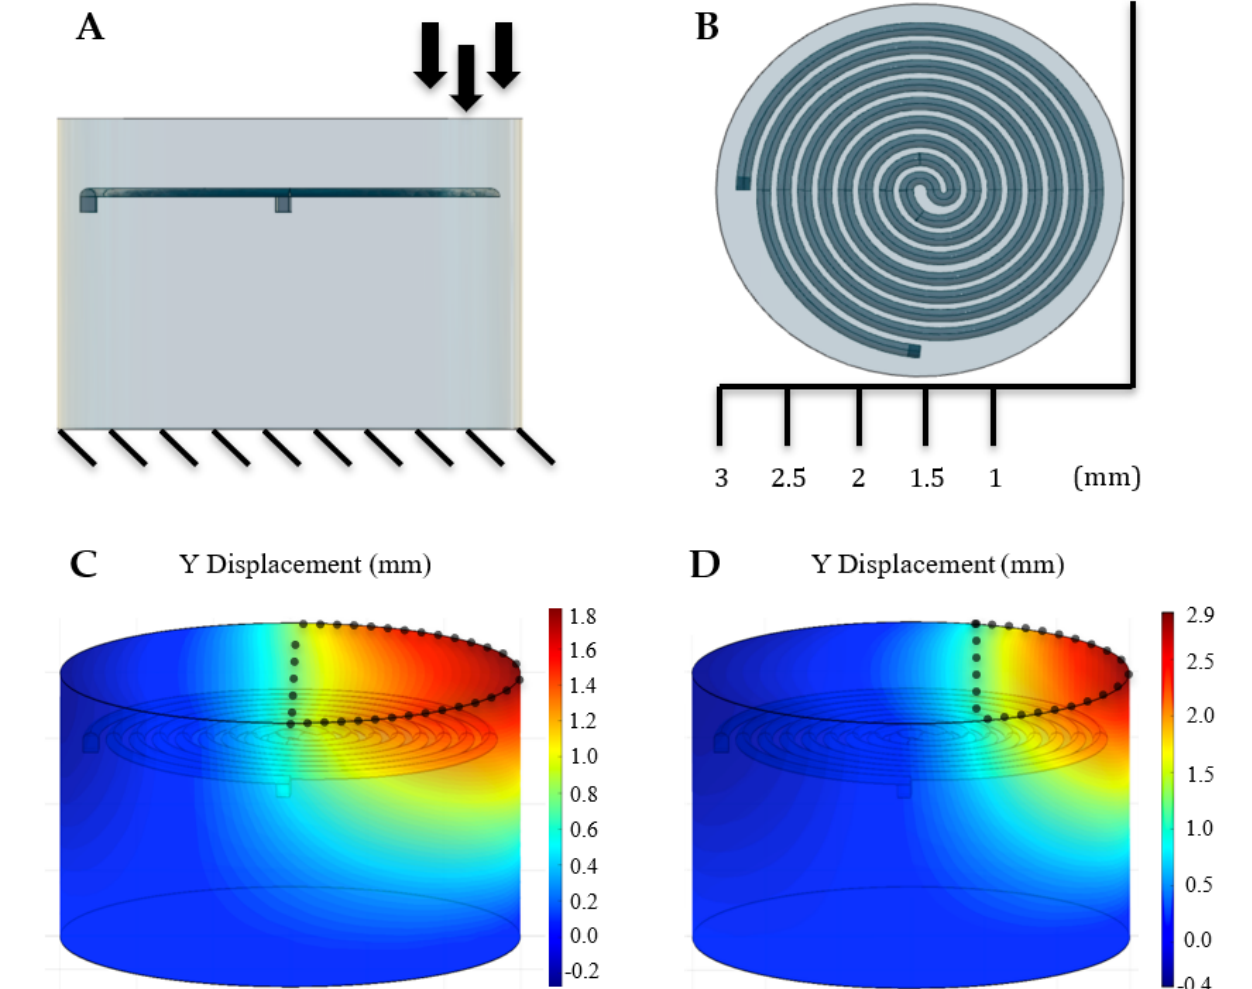
Figure 9. ( A ) A free body diagram displaying the conditions in which the lateral pressure sweep was executed. A constant force of 0.4 N was dispersed between the rightmost boundary of the sensor, and one of the X-positions shown in ( B ). This sweep represents the conditions the sensor would be under if there was an imperfect uniliateral contact of the ablation tip with the heart wall. Having the relationship between resistance and lateral pressure loading would allow adjustments to be made to the output reading if imperfect contact were to occur. ( C , D ) The previously mentioned sweep was simulated using Matlab’s FEA tool. Pressure varied between each simulation to maintain a total force of 0.4 N. The above figures display two completed simulations used for this test. The left figure represents pressure applied to the surface area less than 1.5 mm, or half of the entire sensor. The figure on the right corresponds to values less than 1.0 mm. The total area of force exerted is displayed by the black dotted outline.